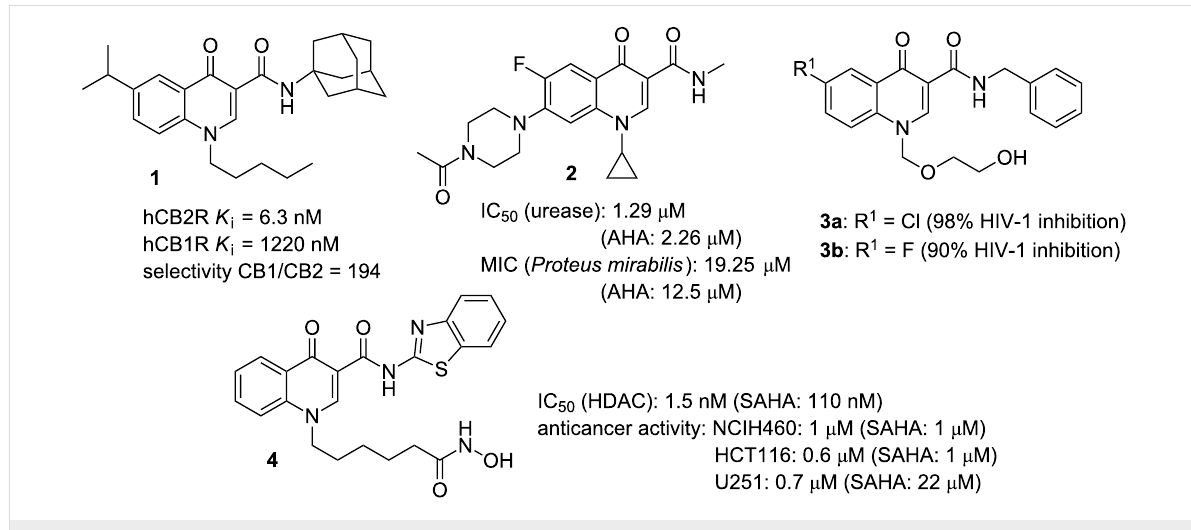
Figure 1: Structures of some bioactive 4-oxoquinoline-3-carboxamide derivatives 1 – 4 with different bioactive profiles. K i = binding affinity; AHA = acetohydroxamic acid (standard urease inhibitor); SAHA = suberoylanilide hydroxamic acid (an FDA approved drug for cutaneous T-cell lymphoma); NCIH460 = lung cancer cell line; HCT116 = colon cancer cell line; U251 = glioma cell